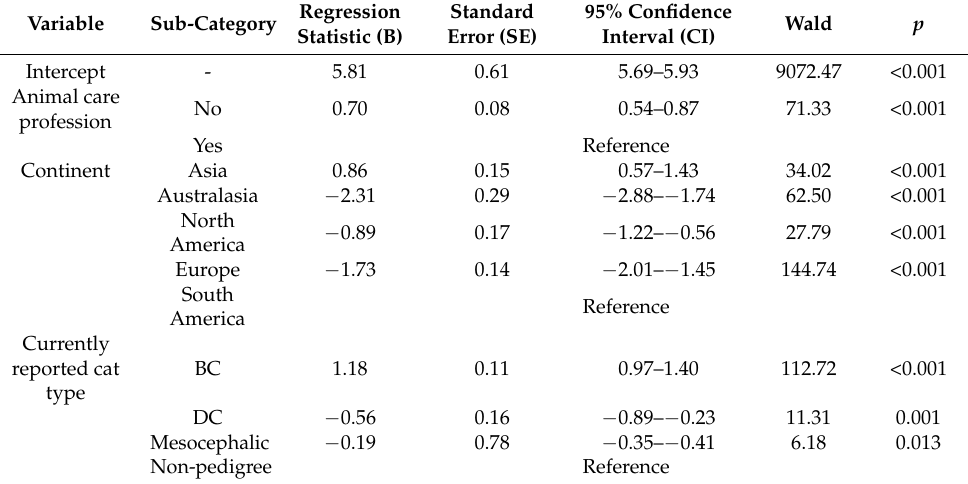
Table 4. Generalized estimating equation of variables that predict the ratings of cats considered to be brachycephalic ( n = 7/15 cat images as per Table 1). The group included cats considered to be mildly, moderately or extremely brachycephalic as scored by a panel of veterinarians ( n = 50; see Table 1). Analyses were conducted taking owner and cat photograph identification (1–15) into account as repeated measures. “Reference” is the sub-category against which those within the same variable were compared. Currently reported cat-type was designated to one of four categories (brachycephalic (BC), mesocephalic, dolichocephalic (DC) or non-pedigree) based on the reported breed of the respondent’s oldest